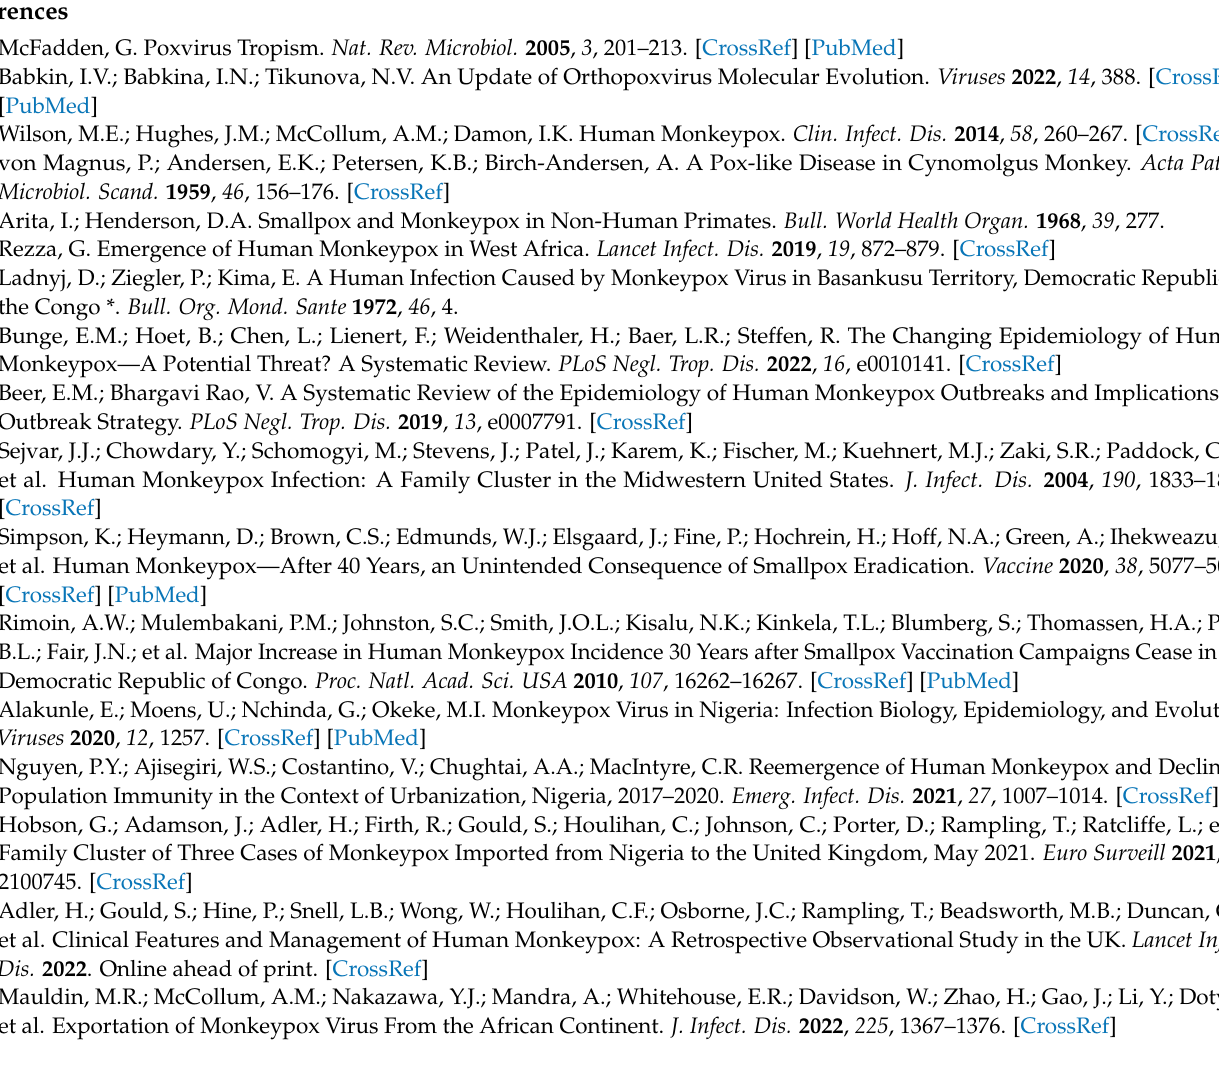
Figure A1. Correlation between relative search volumes (RSV) from Google Trends between 24 Mary and 31 May 2022 and Knowledge score (left; rho = − 0.103, p = 0.189) and Risk Perception score (right; Spearman’s rho = − 0.041; p = 0.605)).